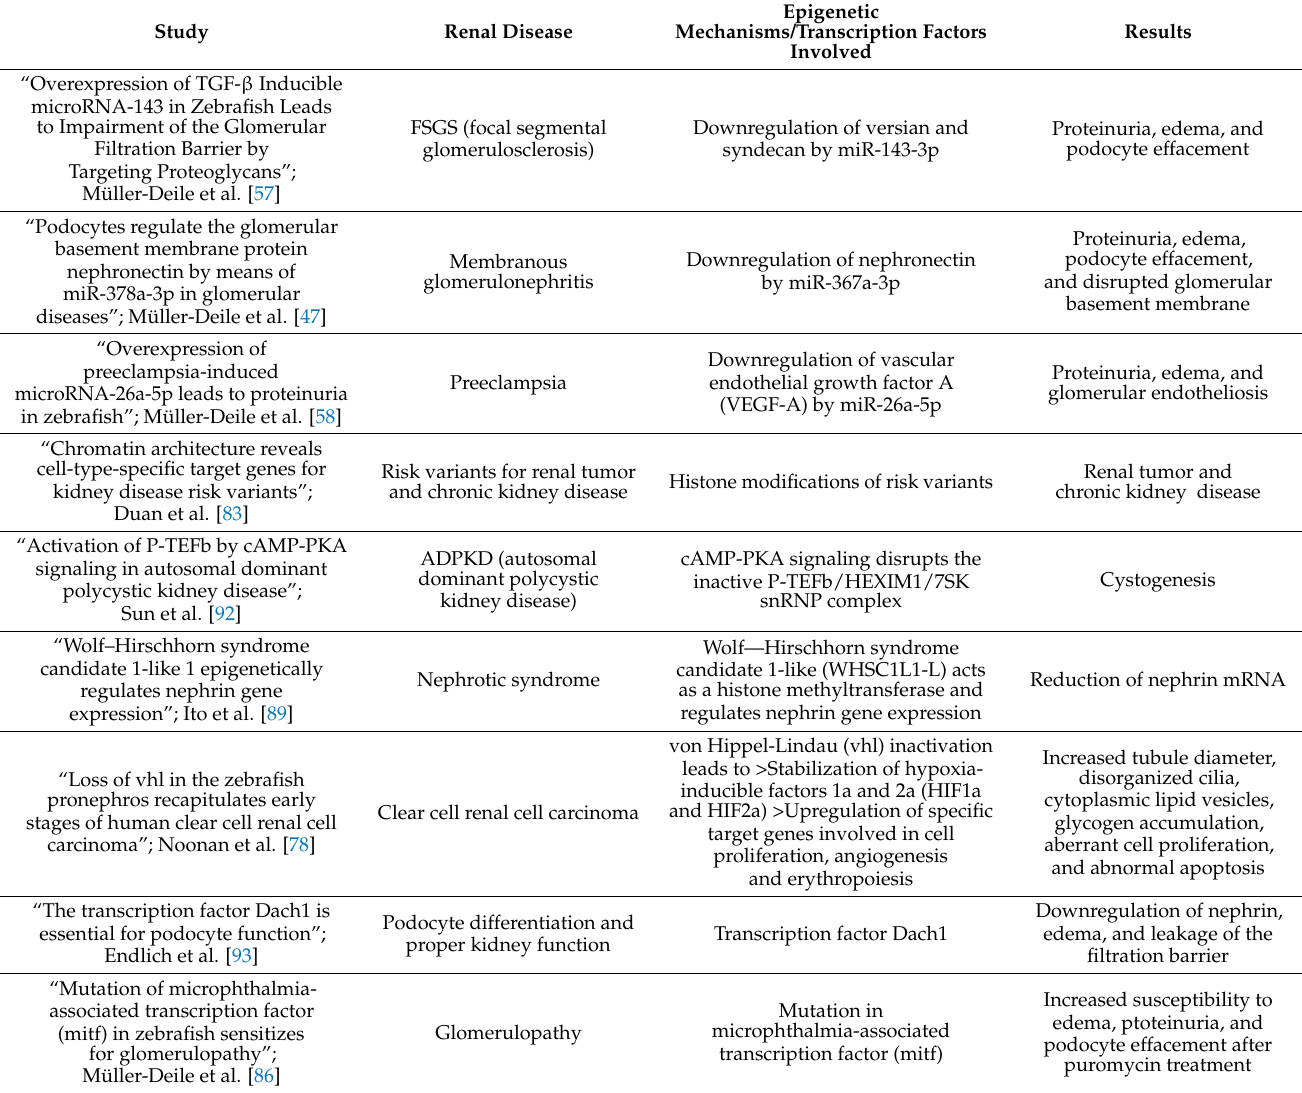
Table 1. Studies using the zebrafish model to study epigenetics and transcription factors in renal